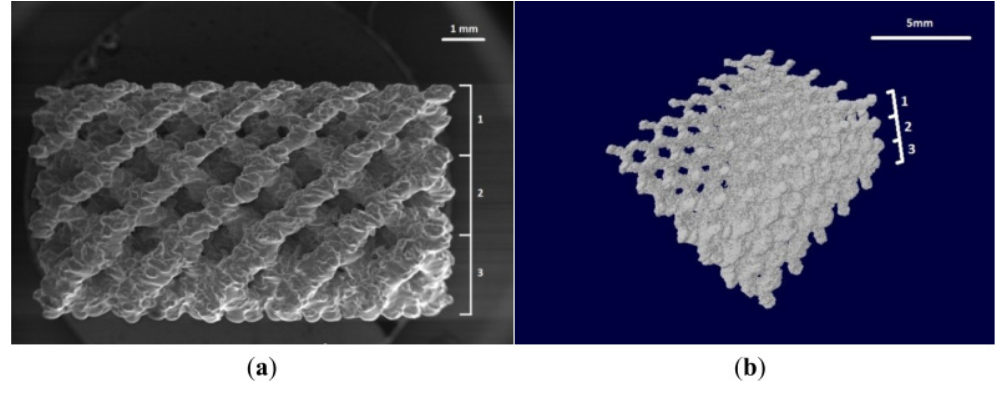
Figure 2. ( a ) SEM image of graded diamond lattice structure; ( b ) Micro CT scan of 3D image shows different strut thicknesses. Adapted from Ref.